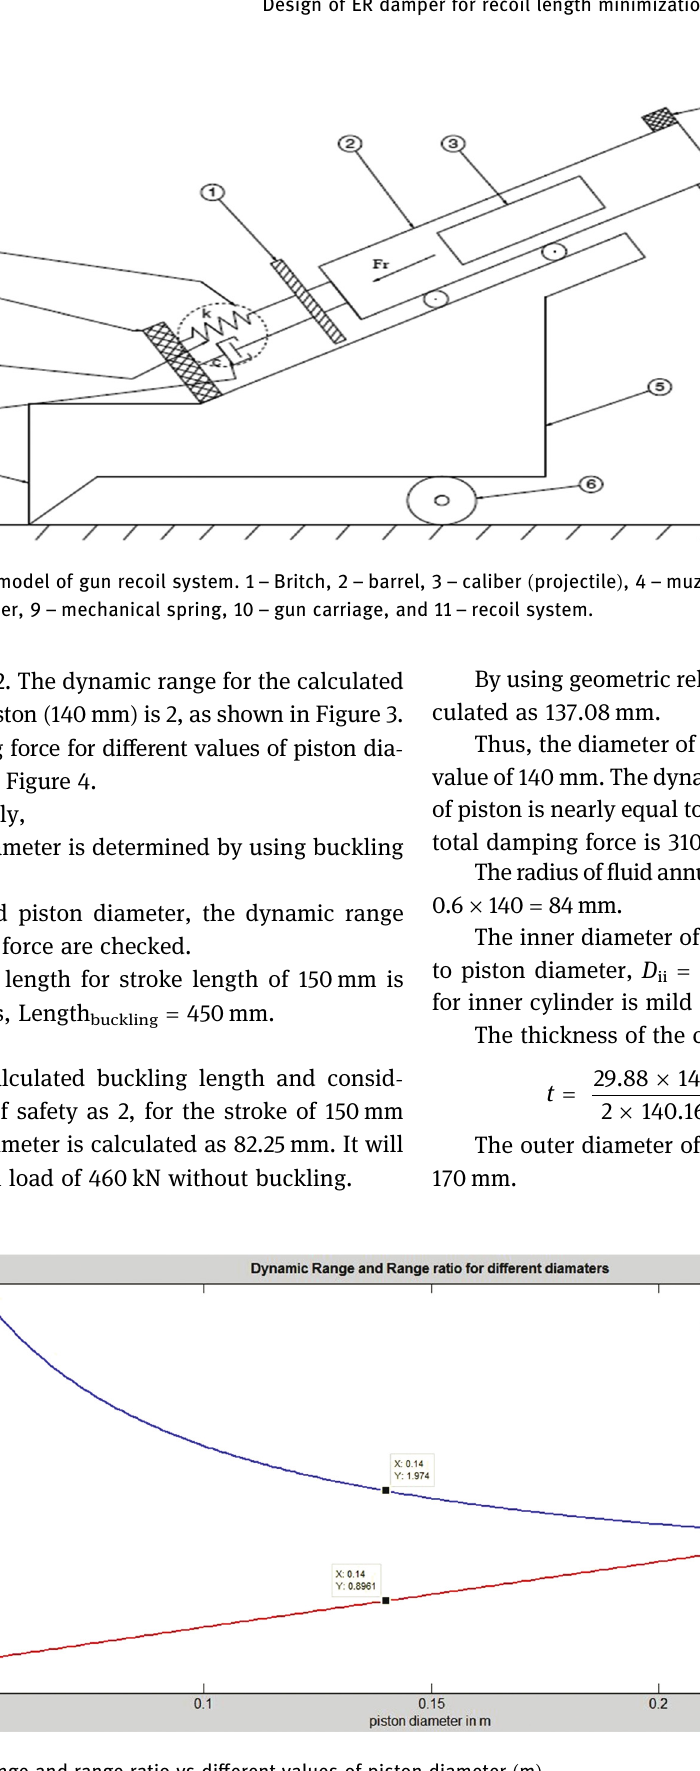
Figure 3: Dynamic range and range ratio vs di ff erent values of piston diameter ( m )